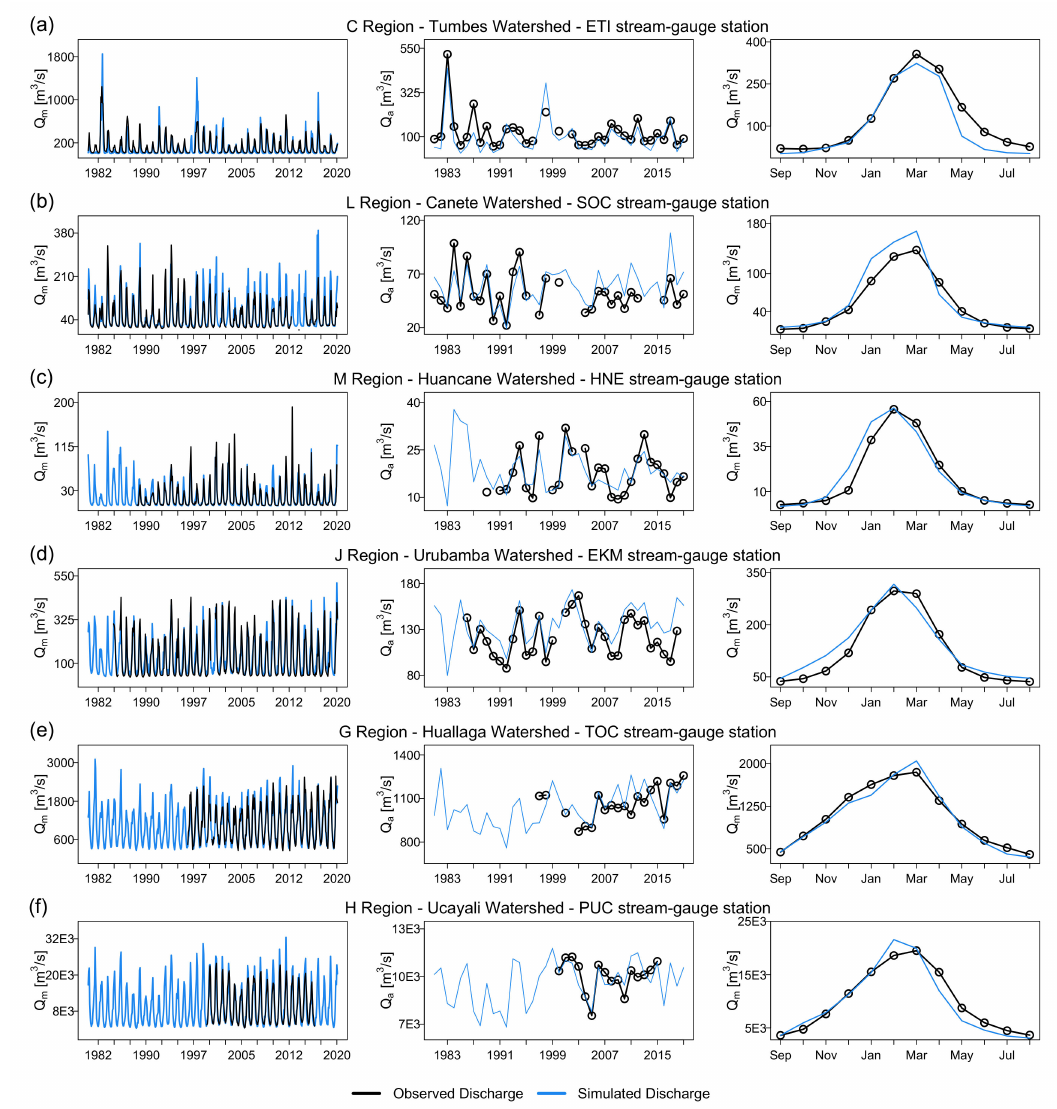
Figure 7. Observed and simulated monthly and annual discharges (Qm), and seasonal variation curves, for six represen- tatives’ hydrometric stations in the ( a , b ) Pacific, ( c ) the Titicaca, and ( d – f ) the Atlantic slopes, with more extended